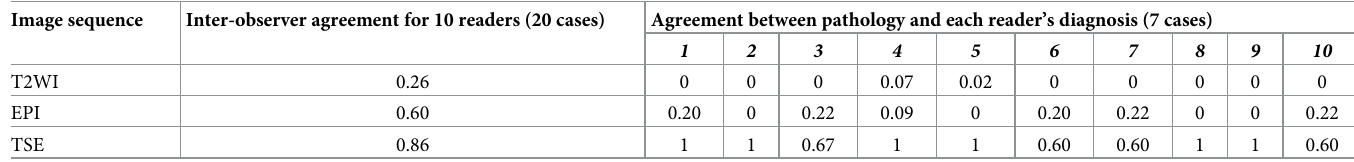
Table 3. Inter-observer agreement of T-staging in all 20 cases and agreement between respective reader’s diagnosis and pathology in 7 cases for three image sequences. Image sequence Inter-observer agreement for 10 readers (20 cases)